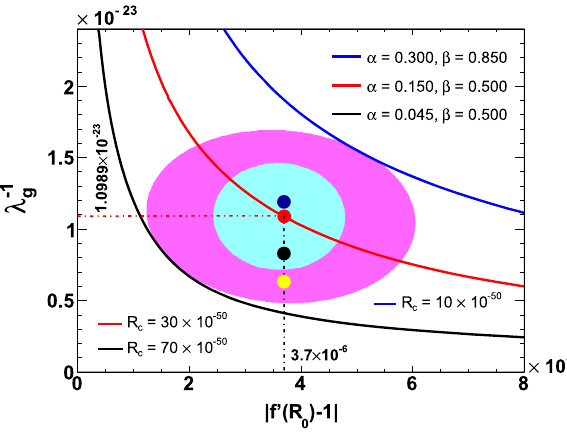
Fig. 14 Contours with 95% confidence level on the upper bounds of f (cid:2) ( R ) − 1 [26] and 90% confidence level on the upper bounds of λ − 1 g [27] (the larger contour) and with 68% confidence level on the both (the smaller contour). The central red dot denotes the λ g corresponding to galaxy cluster Abell 1689 [27], blue dot corresponds to Abell 262, black one corresponds to Abell 1991 and yellow one corresponds to Abell 383 [28]